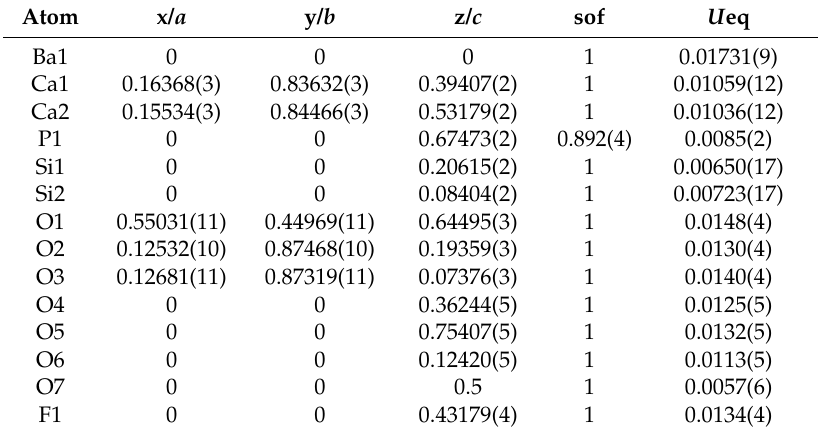
Table 3. Atom coordinates, U eq (Å 2 ) values for ariegilatite.